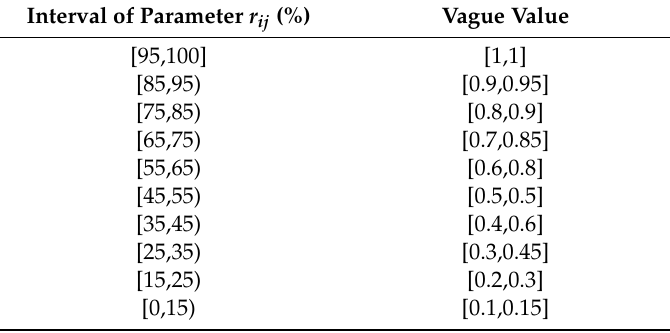
Table 1. The corresponding relationship between parameter r ij and the vague value. Interval of Parameter r ij